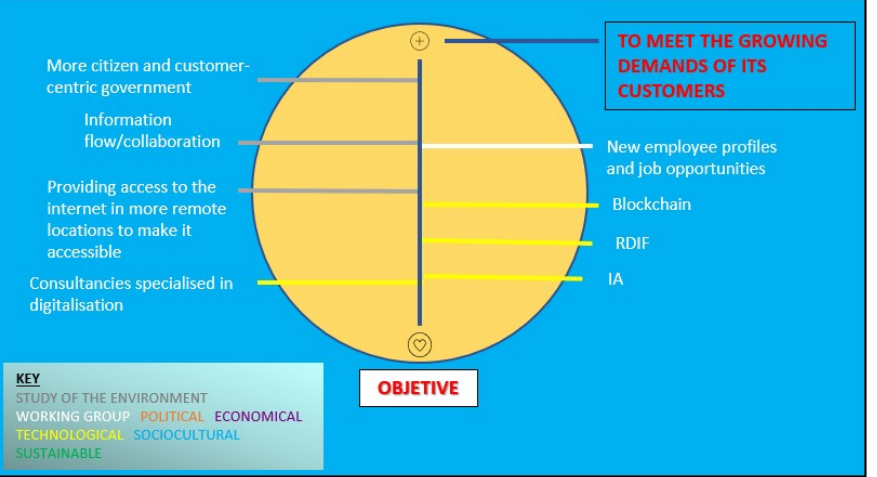
Figure 18. Elements of ports to meet the growing demands of their customers. Source: own elaboration. Flexible ports will need technological, political, working group, economical, sociocultural and sustainable indicators. In the economic block, the reference indicator is new business models. Once again, new employee profiles and job opportunities and cultural change will be necessary to achieve more flexible ports. In the political block, government initiatives will be very important, along with the adaptation of new port models.